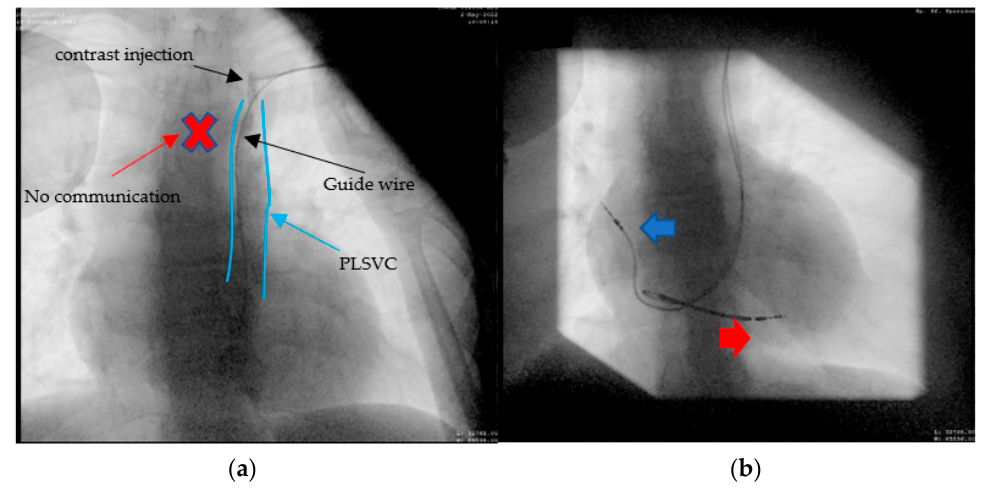
Figure 6. ( a ) The passage of the guide wire to the left side of the spine and then the venography confirming the presence of PLSVC, no communication with the right vena cava can be seen; ( b ) the defibrillation leads can be seen on the trajectory of the left superior vena cava (LSVC), through the coronary sinus (CS) into the right ventricular apex (RV)—red arrow. The atrial lead can be seen through the LSVC, coronary sinus, and right ventricle in the right atrial appendage (RA)—blue arrow.